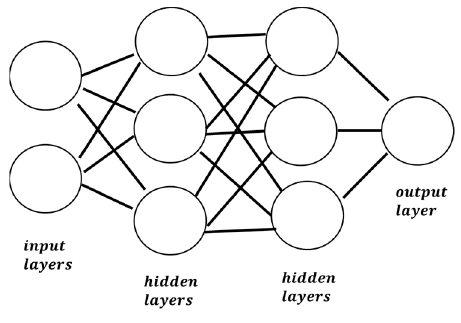
Figure 3. An example of neural network.